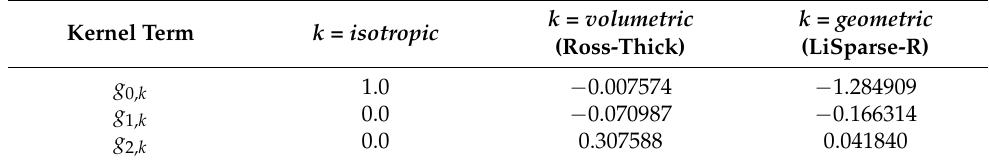
Table 3. Black-sky albedo coefficients from [85].